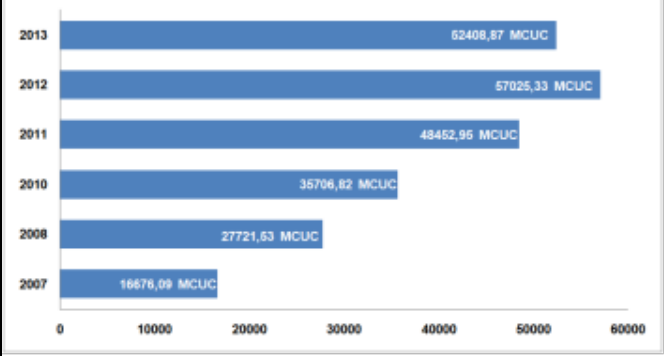
Figura 4: Importe total de Ventas en MCUC de ECASOL a sus